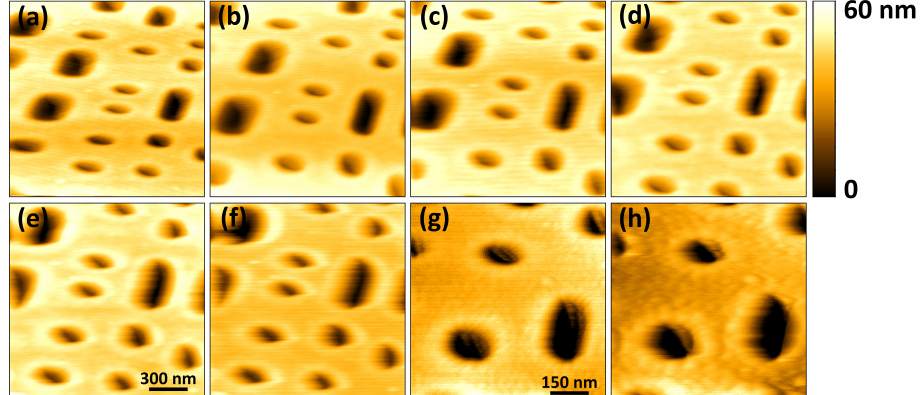
Figure 9. Topographical images of a Blu-ray disk sample consisting of 256 × 256 pixels acquired at different line rates. The scan area is 1 µ m × 1 µ m for images ( a – f ) and 0.75 µ m × 0.75 µ m for images ( g , h ). The scan rates in Hz are ( a ) 2; ( b ) 5; ( c ) 10; ( d ) 20; ( e ) 40; ( f ) 50; ( g ) 50, and ( h )